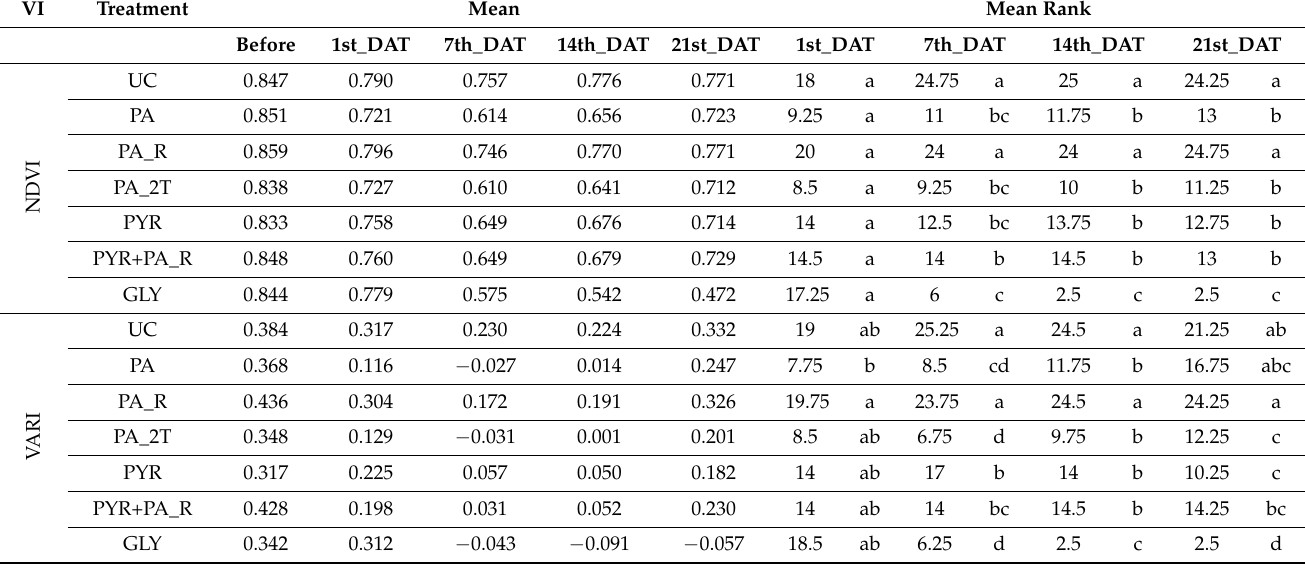
Table A1. Results of a comparison of treatments using absolute values of vegetation indices at different DATs in